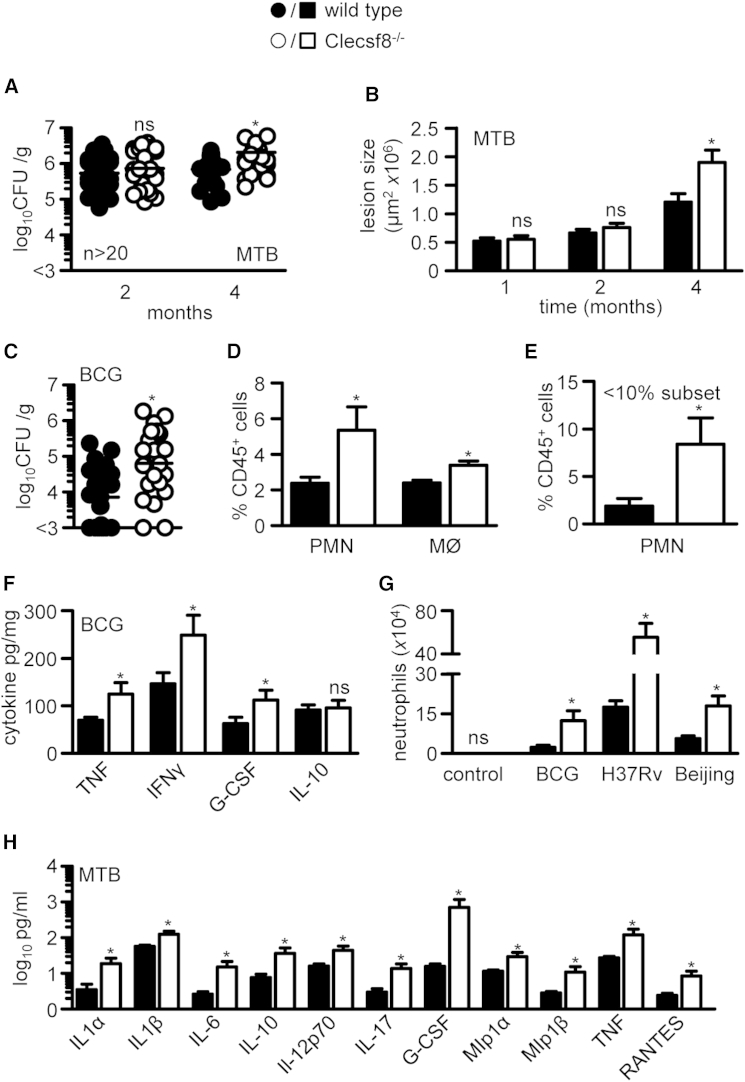
Clecsf8 Deficiency Results in Exacerbated Pulmonary Inflammation with Increased Accumulation of Neutrophils and Higher Bacterial Burdens(A) Pulmonary bacterial burdens in wild-type (WT) or Clecsf8−/− mice following aerosol infection with 100 CFU M. tuberculosis H37Rv.(B) Pulmonary inflammatory lesion size over time. Pulmonary bacterial burdens (C) and leukocyte composition (D) in WT or Clecsf8−/− mice 3 months following i.t. infection with 5 × 105M. bovis BCG.(E) Neutrophil levels in WT (n = 3) and Clecsf8−/− (n = 8) animals that show the greatest change in body weight (< 10%).(F) Pulmonary cytokine levels in 3-month M. bovis BCG-infected animals.(G) Pulmonary leukocyte composition in WT or Clecsf8−/− mice 48 hr after i.t. infection with M. bovis BCG, M. tuberculosis H37Rv, or Beijing, as indicated.(H) BAL cytokine levels in mice at 48 hr after infection with M. tuberculosis H37Rv. Shown are pooled data (mean ± SEM). ∗p < 0.05. ns, not significant. See also Figure S2.